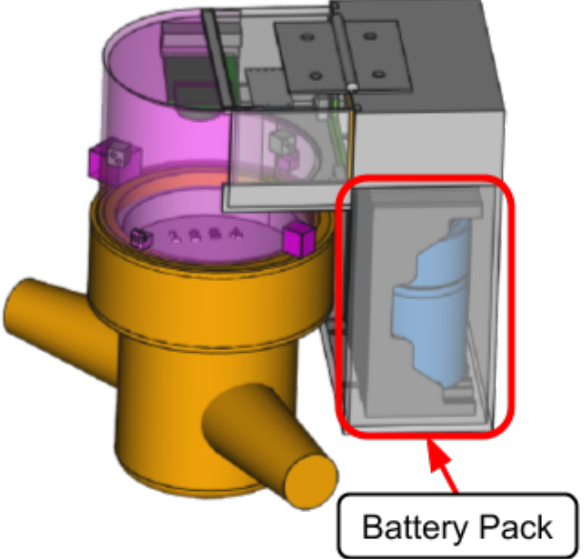
Figure 4. Three dimensional model of a “Dumb” water meter equipped with the SWaMM ORK module.